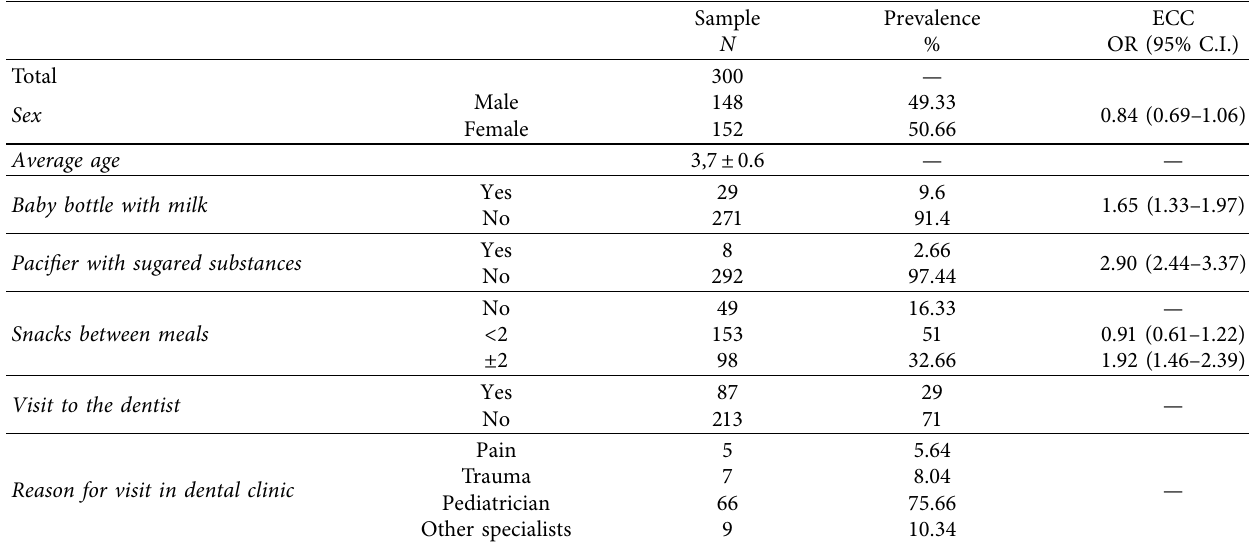
Table 1: Descriptive data of the sample study and odd ratio for early child caries [1].